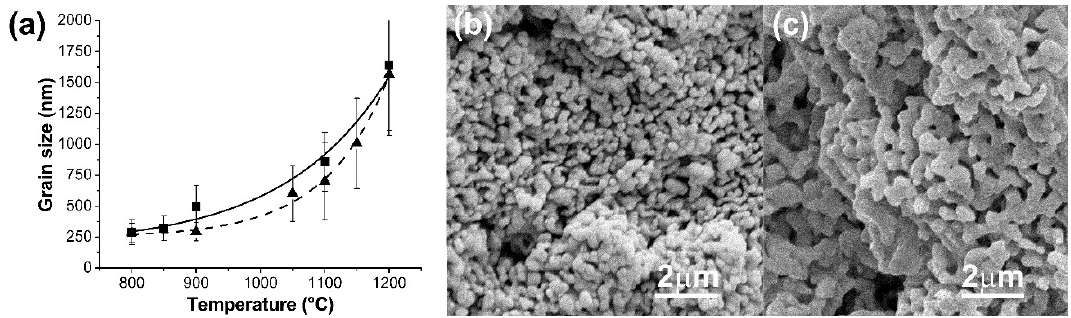
Figure 5. a ) Dependence between grain size and sintering temperature for scaffolds of HA: ‐  ‐ 20 Dash line; - (cid:4) - 40wt.% Full line. ( b , c ) FESEM micrographs of HA/ β -TCP scaffolds ( b ) 80HA/20 β -TCP, wt.%, Dash line; ‐  ‐ 40wt.% Full line. b ) and c ) FESEM micrographs of HA/  ‐ TCP scaffolds b ) ( c ) 20HA/80 β -TCP. 80HA/20 β‐ TCP, c ) 20HA/80 β‐ TCP.